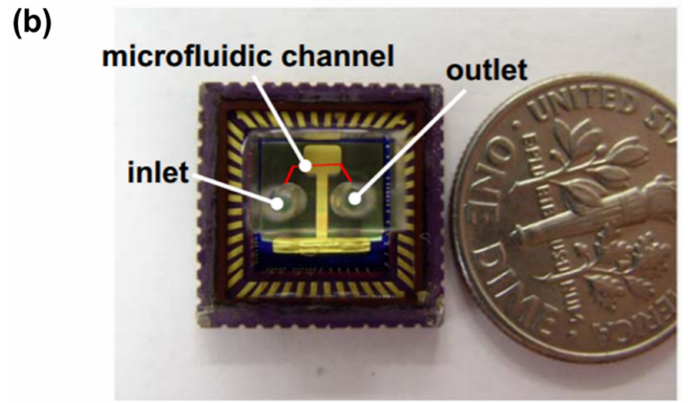
Figure 6. On chip OFM system for the detection of protozoan parasites in drinking water. Detection of disease-causing parasite species like Caenorhabditis elegans and Giardia lamblia was demonstrated using OFM technology. ( a ) Cross section view of the OFM device; ( b ) photo of the fabricated on-chip OFM device